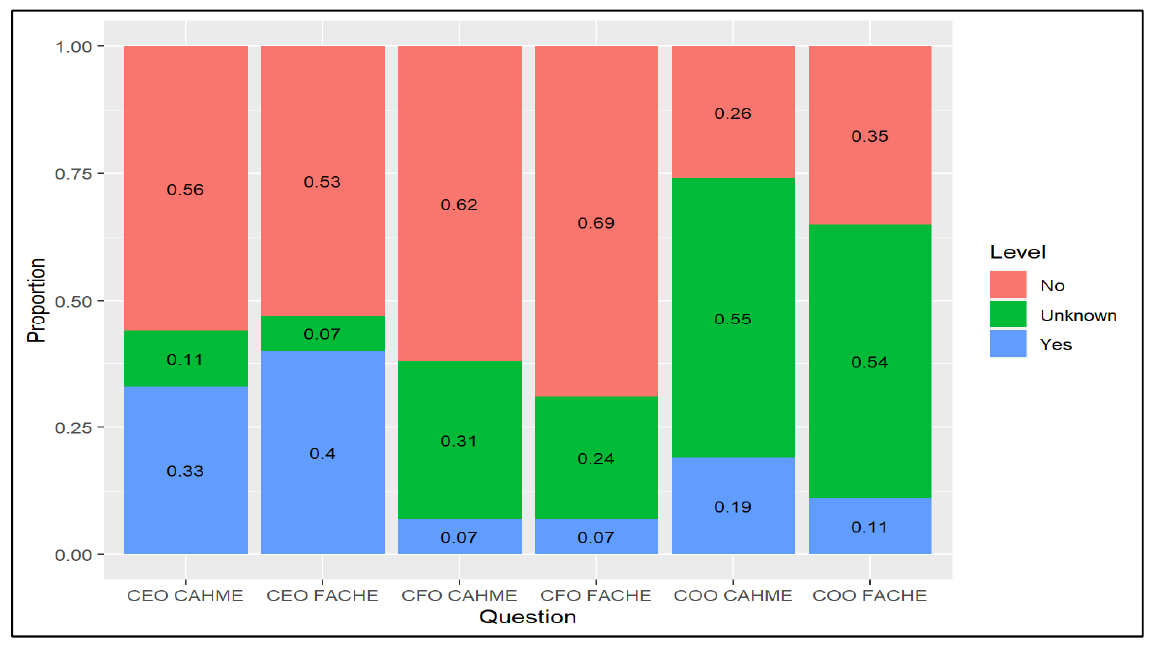
Figure 2. Status of CAHME/FACHE.